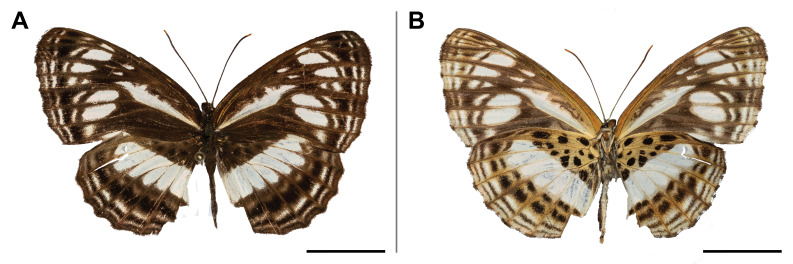
Neptis
metella (Doubleday, [1850]). A. dorsal view; B. ventral view. The scale bar represents 1 cm.